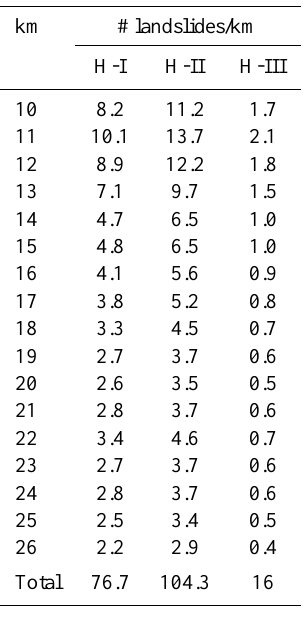
Table 3. Landslide hazard along the road in T 50 years return period. Road